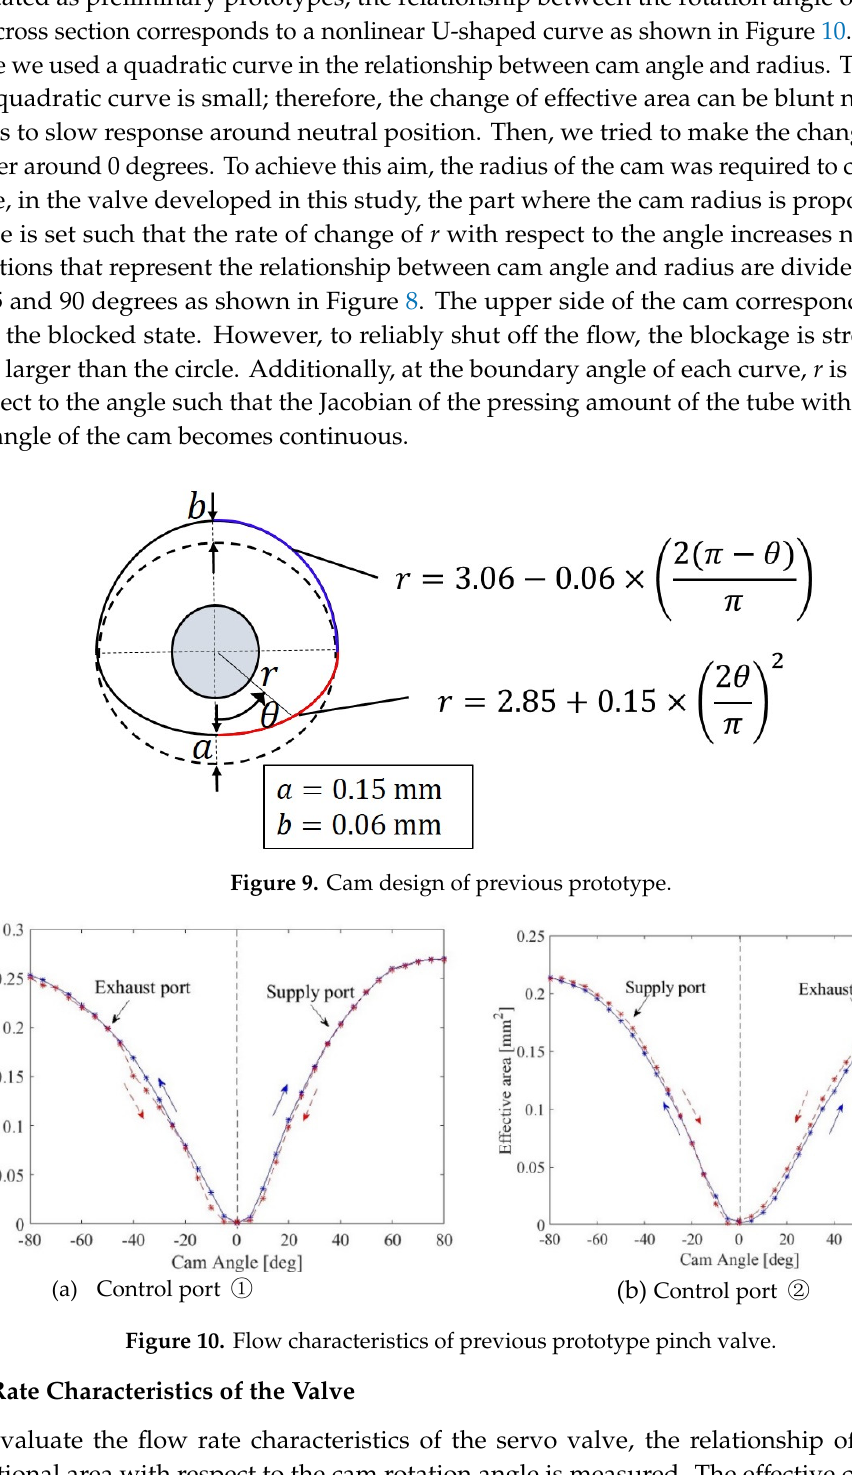
Figure 11. Flow characteristics of developed pinch-type valve.